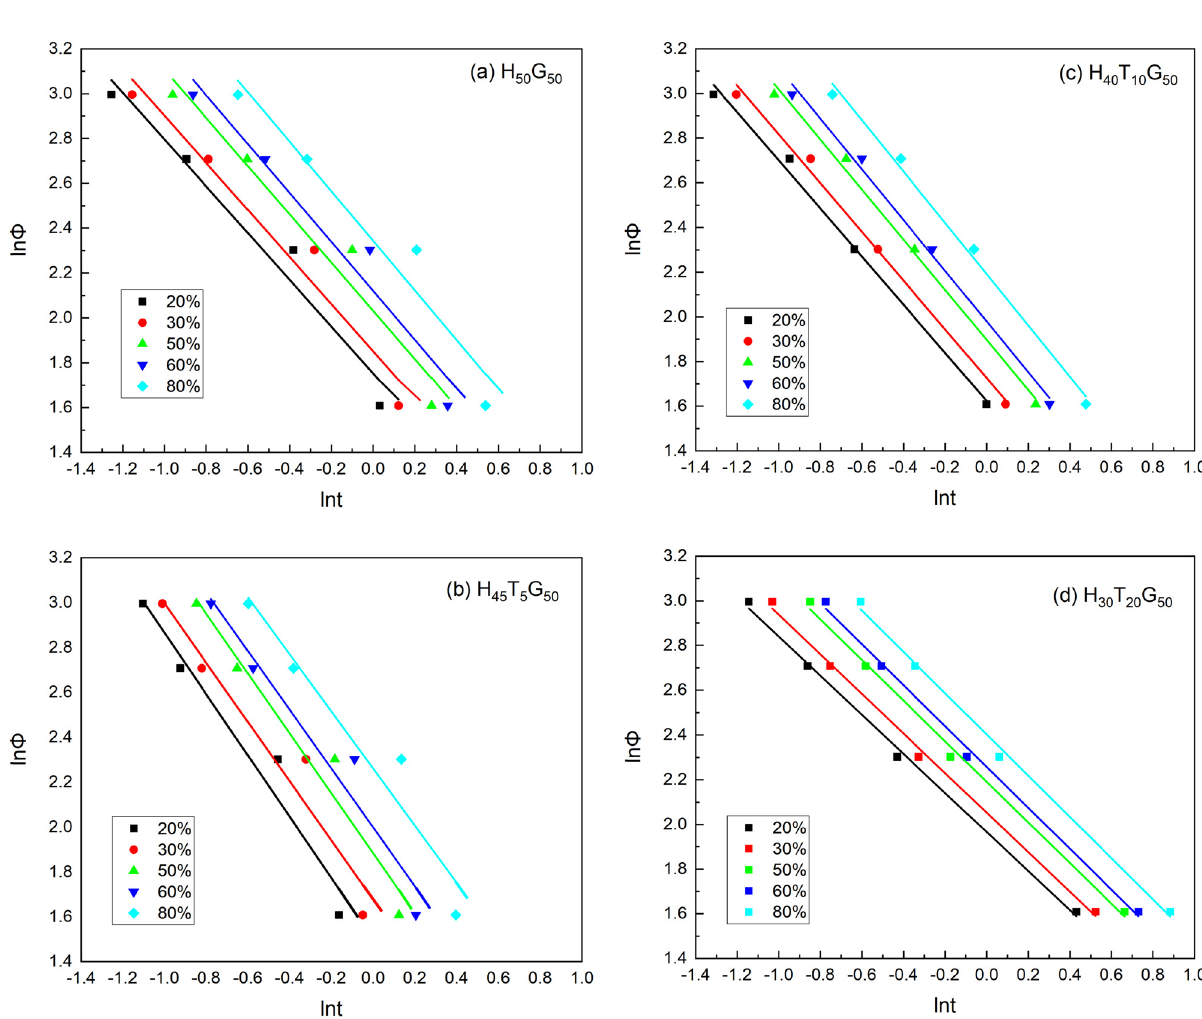
Figure 5: Plots of φ lg versus t lg for the cold crystallization of H 50 G 50 ( a ) , H 45 T 5 G 50 ( b ) , H 40 T 10 G 50 ( c ) , and H 30 T 20 G 50 ( d )